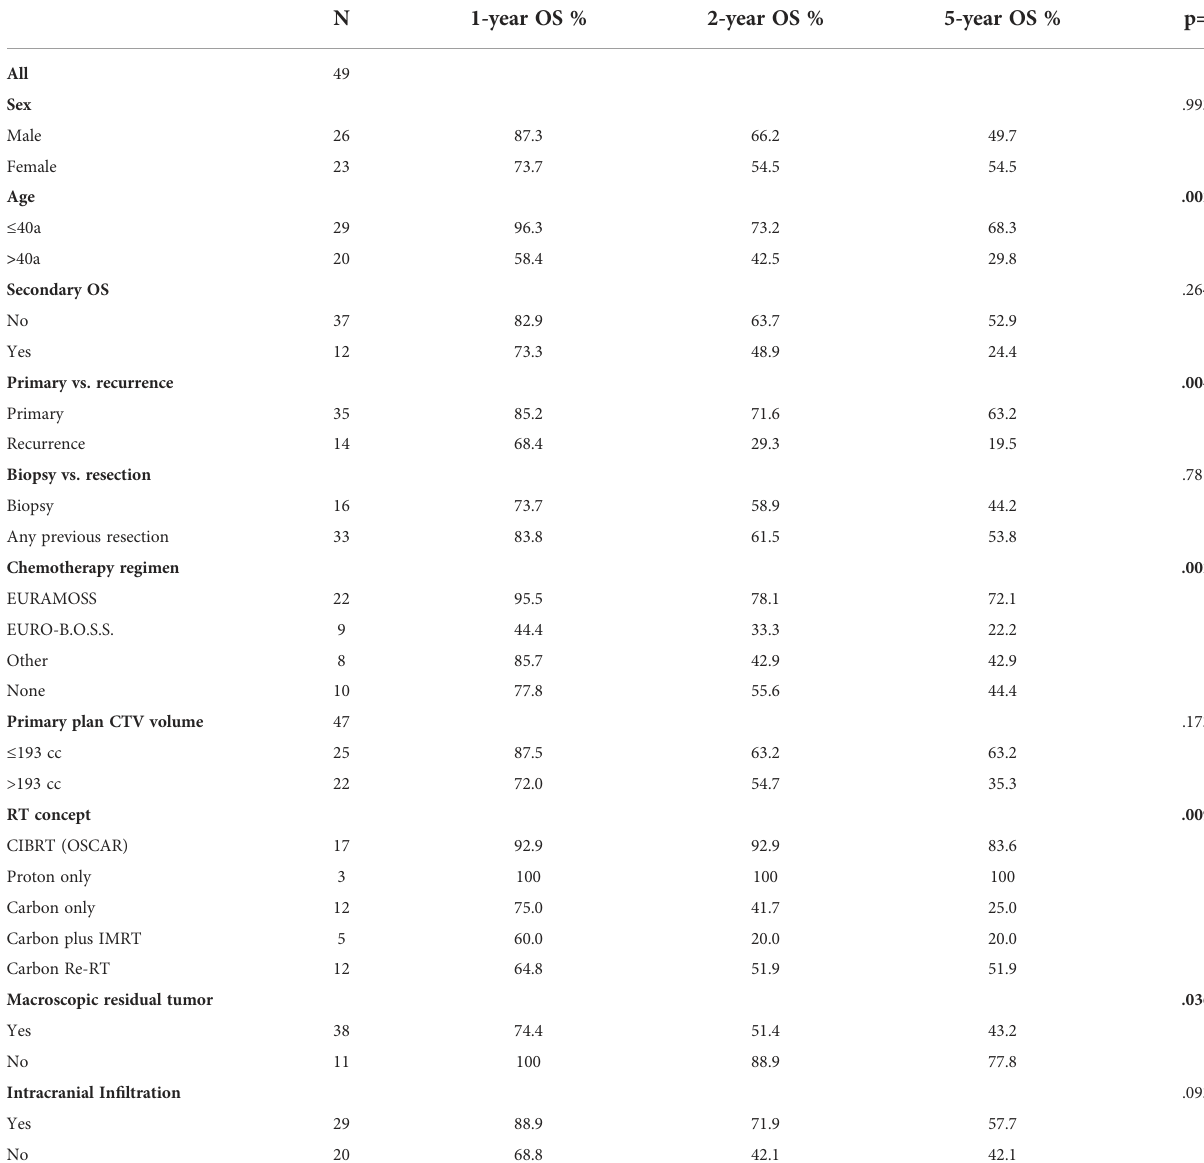
TABLE 2 Univariate analysis of factors in fl uencing